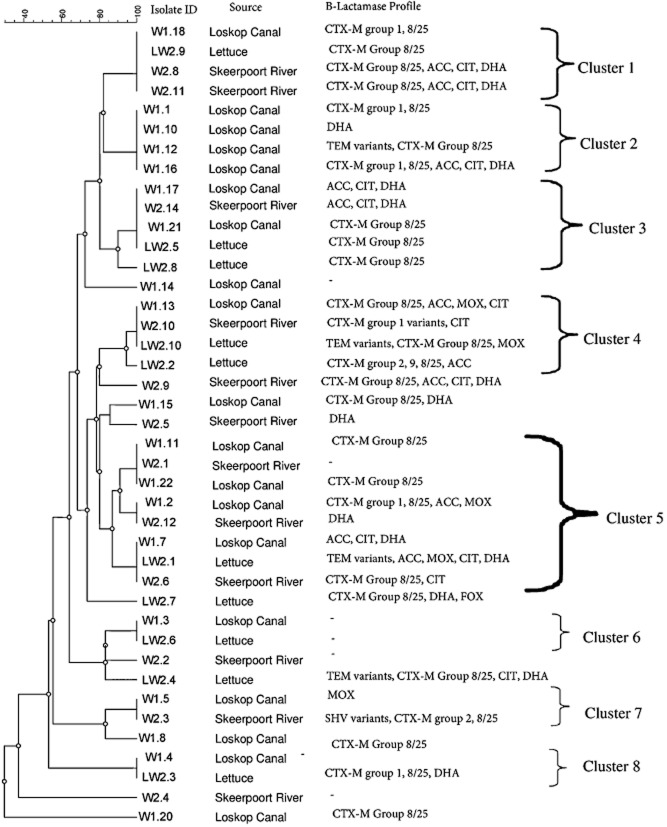
Dendrogram for REP-PCR fingerprints of E. coli isolates obtained from irrigation water and lettuce and their ESBL/AmpC β-lactamase resistance profilesa. Calculations were based on the Jaccard similarity coefficient using an unweighted pair group method with arithmetic average dendrogram type, 1.30% position tolerance and 2.00% optimization. aVariants explained in Table 1 footnote. Clusters defined at ≥ 85% similarity.